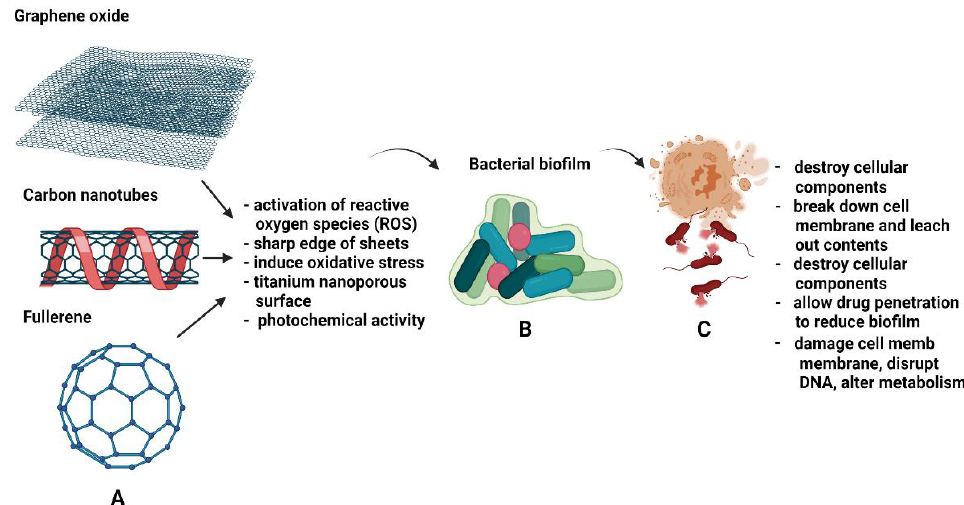
Figure 4. Schematic of ( A , B ) the types of carbon-based nanoparticles and mechanisms used by nanoparticles to exert antibacterial activity against biofilms. ( C ) The effects of bacterial cells after nanoparticles penetrate the biofilm.